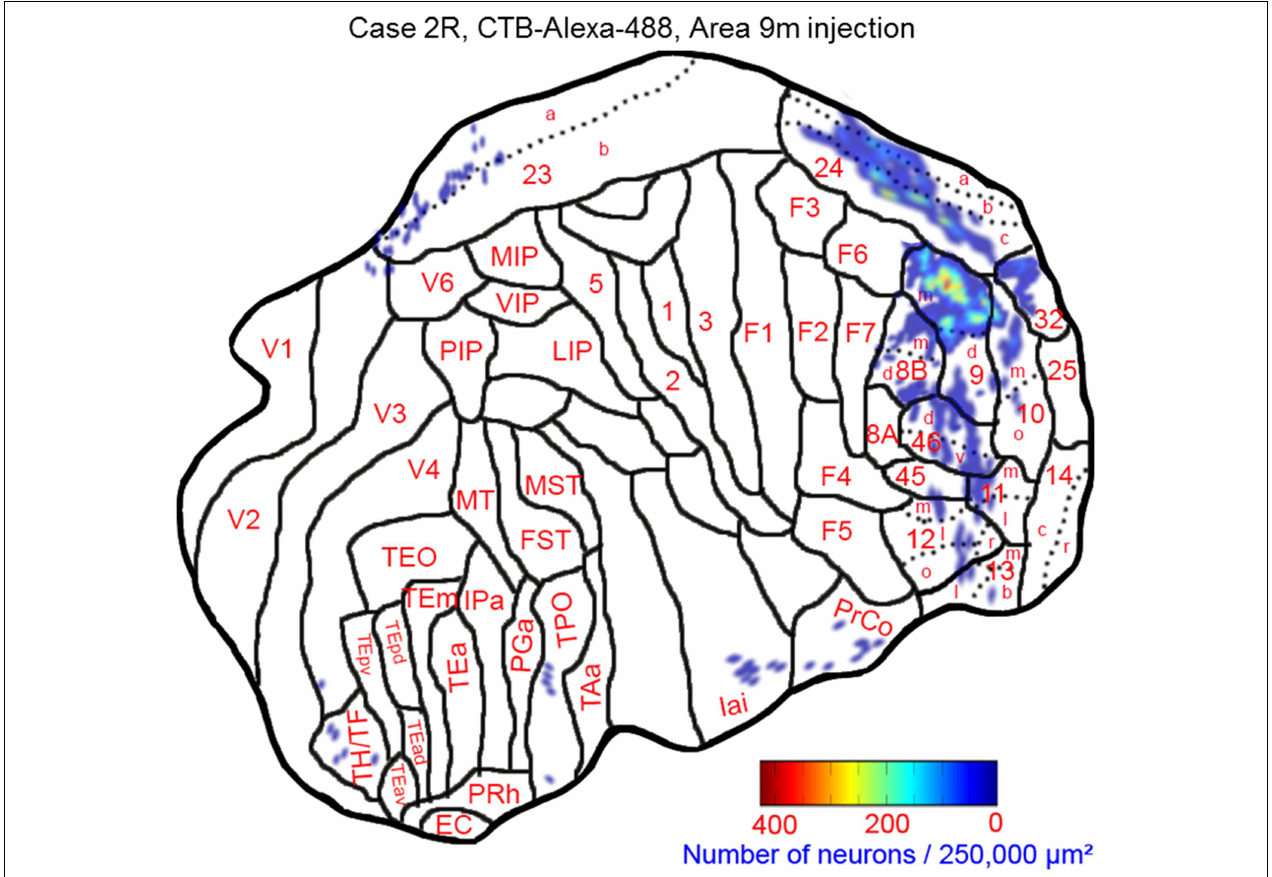
FIGURE 5 | Distribution of retrogradely labeled neurons on the flat map of the cerebral cortex in Case 2R. The density of labeled neurons was converted into a